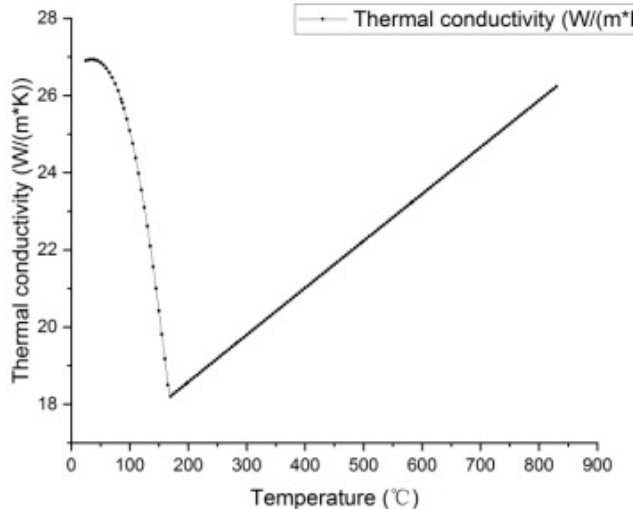
Figure 6. Cooling curve of node 1.